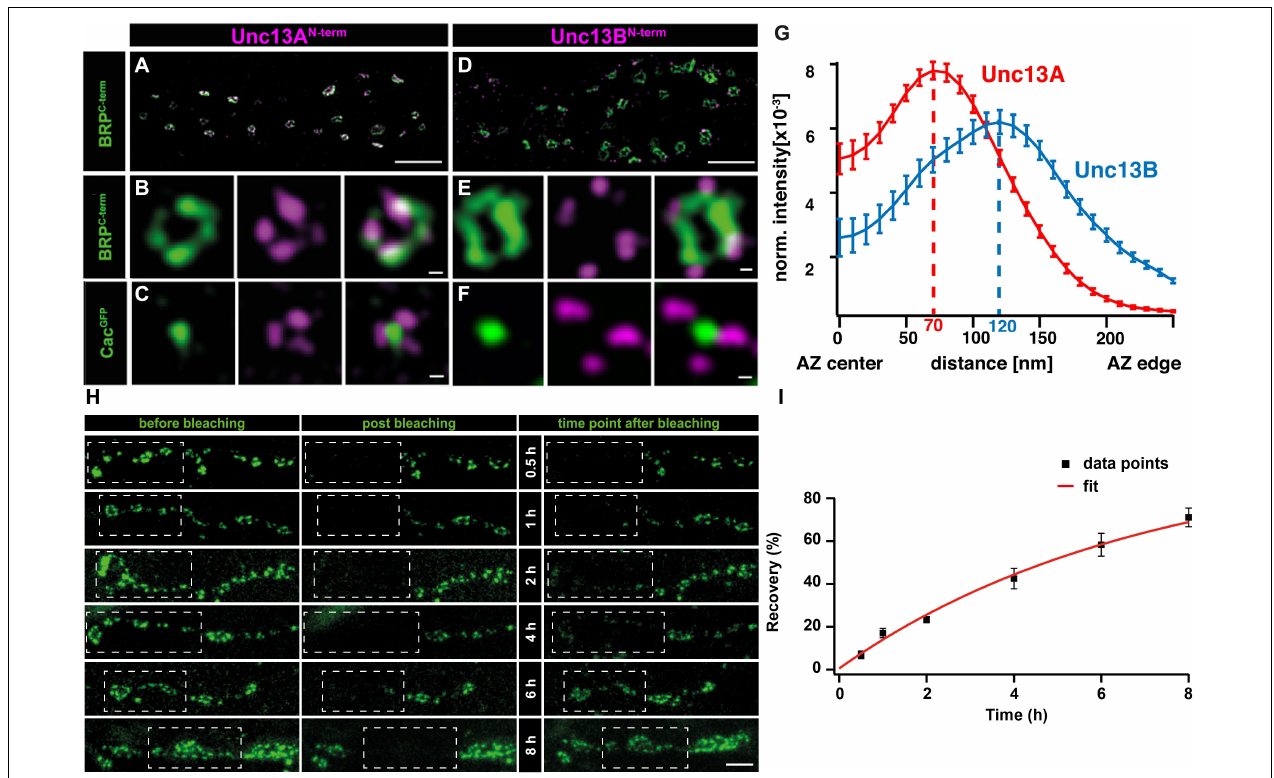
FIGURE 2 | Stable and specific positioning of Unc13A and B at Drosophila NMJ synapses. (A,D) Two-color STED microscopy images of synaptic boutons or individual planar AZs (B,C,E,F) from third instar larvae of the displayed genotypes labeled with antibodies to indicated proteins. (G) Mean intensity profile of Unc13A and Unc13B immunoreactivity plotted from the center of the AZ (the reference center being that of the BRP signal). The intensity maximum of the average fluorescence profile was found 70 nm from the AZ center for Unc13A and at 120 nm for Unc13B. Scale bars: (A,D) : 1.5 µ m; (B,C,E,F) :50 nm; (H) 250 nm (Modified from Böhme et al., 2016). (H) Long-term FRAP of motoneuronally overexpressed Unc13A-GFP at muscle 26/27 depicts a stable integration of Unc13A that requires hours to recover completely. Dashed box shows bleached bouton before and directly after the fluorescence bleaching. Fluorescence recovery was measured 0.5; 1; 2; 4; 6; or 8 h after bleaching. Different time points were measured in different animals. (I) Quantification of percentage recovery over time. Bleached Unc13A-GFP showed a slow fluorescence recovery, exhibiting a tau of 6.88 ± 0.55 h, single exponential recovery fit. Data are mean ± SEM. Scale bar:5 µ m (Modified